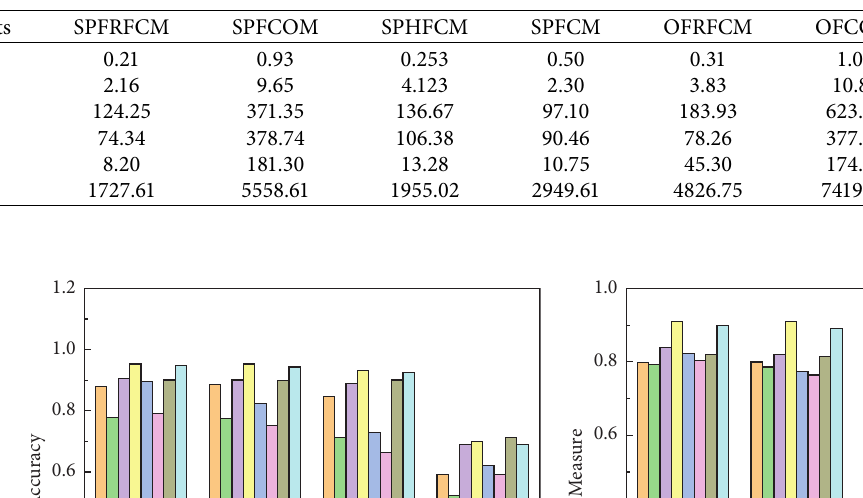
Table 4: Comparison of running time.